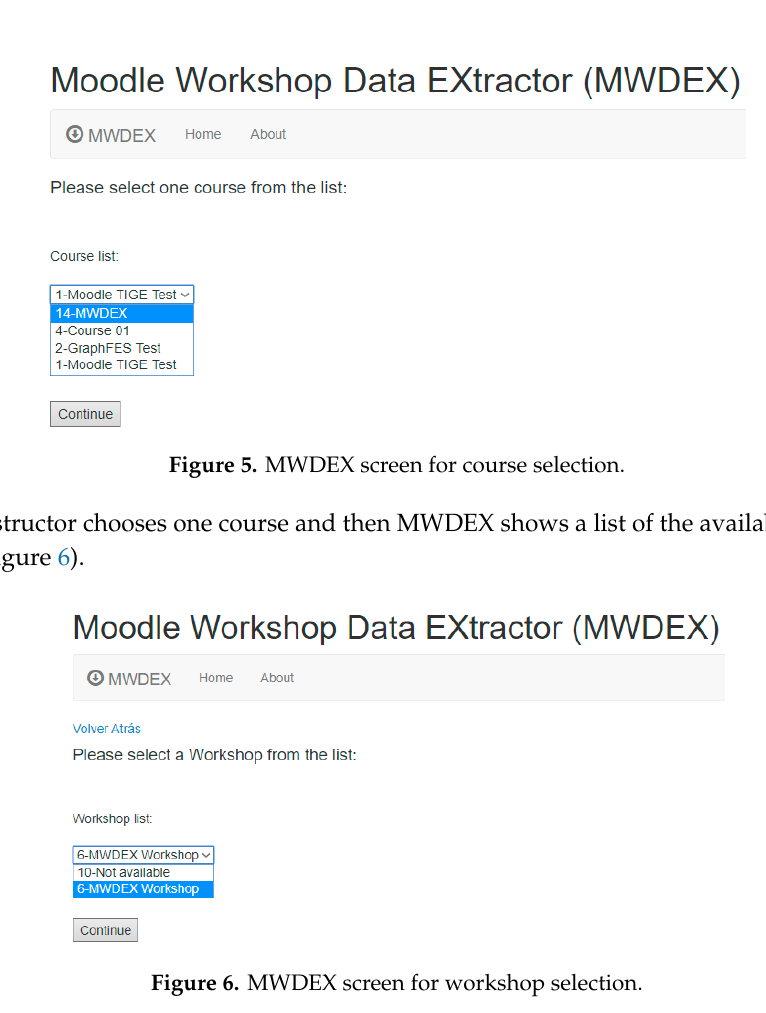
Figure 7. List of enrolled students (edited due to size limitations) and output selection.